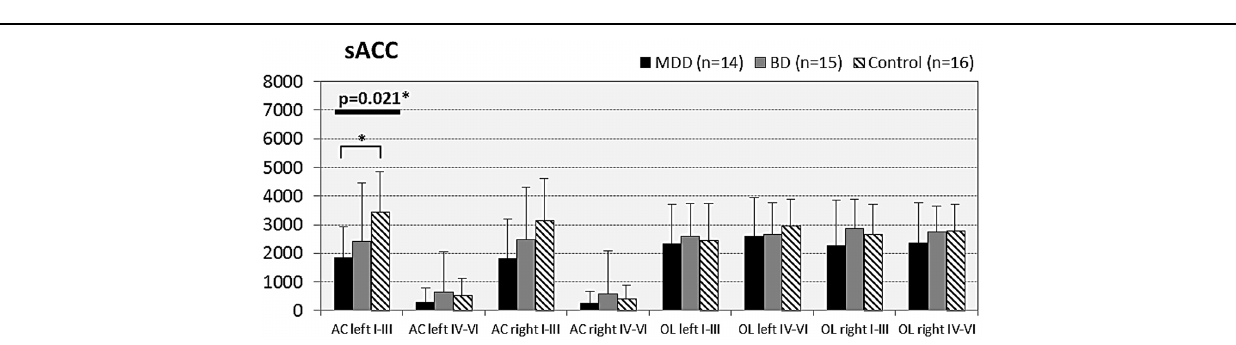
Frontiers in Cellular Neuroscience |